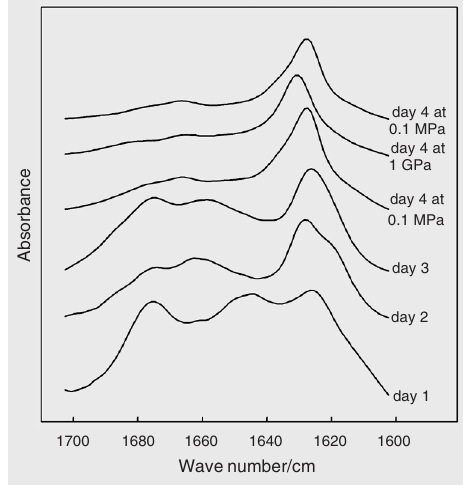
Figure 2. The amide I’ region of the FTIR spectrum of transthyre- tin 105-115 peptide as a function of time and pressure. At day 1, the pressure strongly affects the spectrum (data not shown). At day 4, pressure effects are only affecting the vibrations of the hy- drogen-bonded C=O groups of the peptide bond, indicating no substantial changes in confor- mation of the protein. Effects are reversible as indicated. High hy- drostatic pressure was gener- ated in a diamond anvil